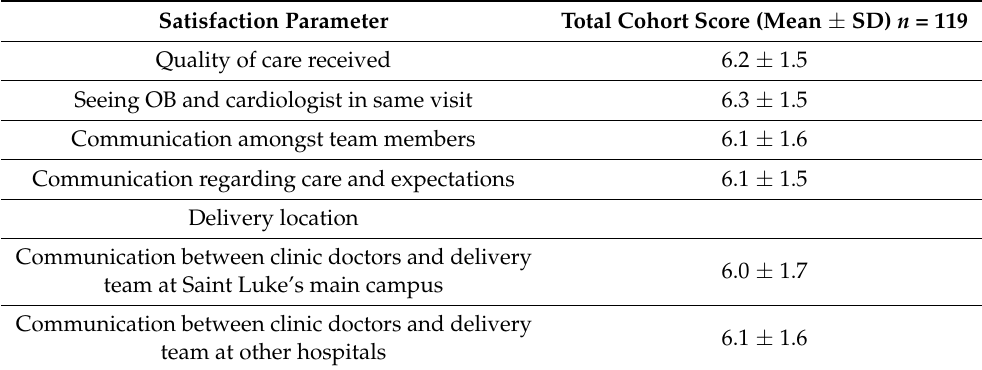
Table 4. Patient satisfaction with combined Cardio-Obstetrics clinic of Saint Luke’s Hospital of Kansas City, based on scale of